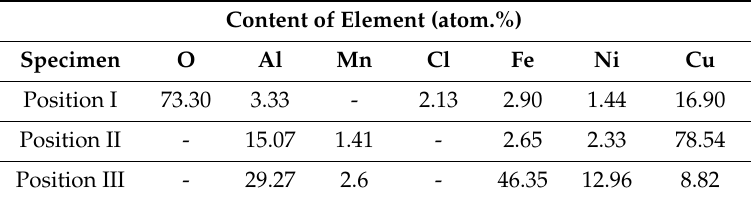
Table 6. The composition of S-Defect immersed in artificial seawater for 3 h. Content of Element